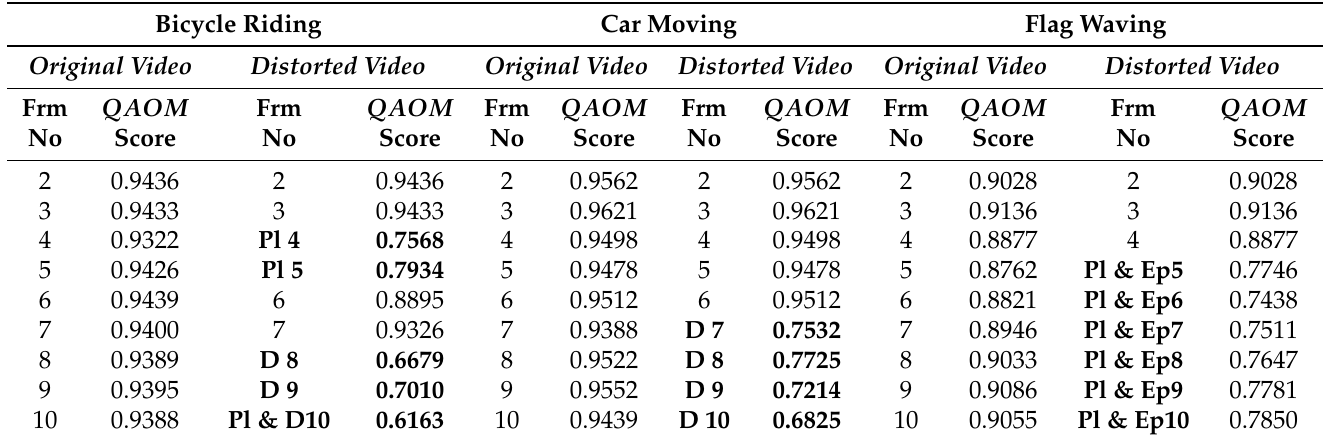
Table 3. QAOM 3 D scores for original and distorted videos from Bicycle Riding, Car Moving, and Flag Waving datasets.